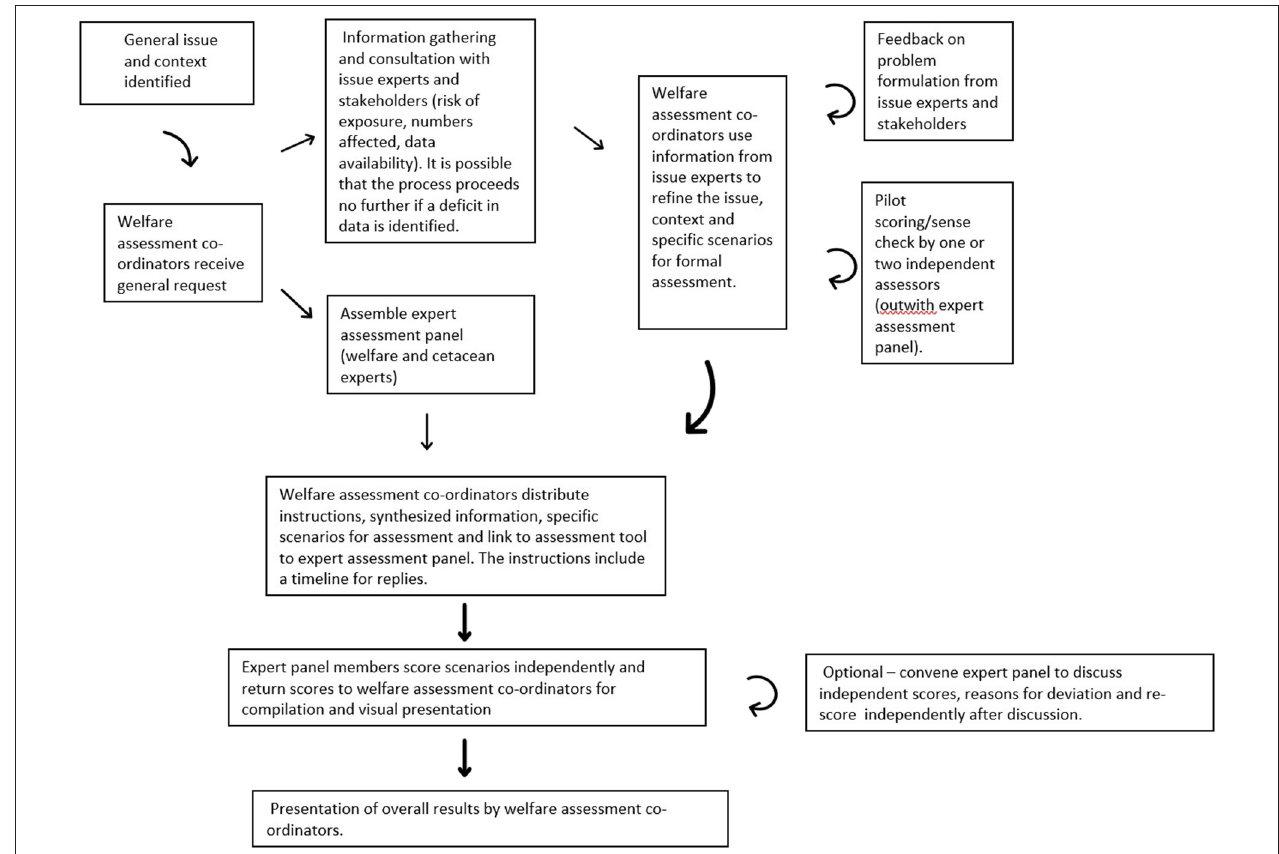
FIGURE 5 | Suggested process that could be followed to implement the welfare assessment tool for wild cetaceans (WATWC) to assess new